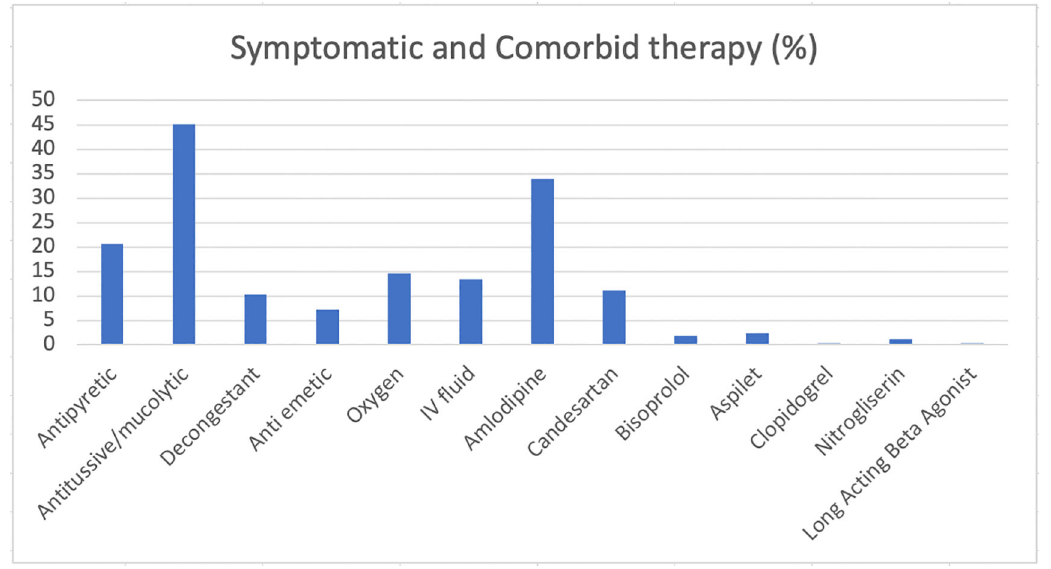
Figure 1. Therapies performed to treat COVID-19 symptoms and comorbidities of the patients during the hospital admission.